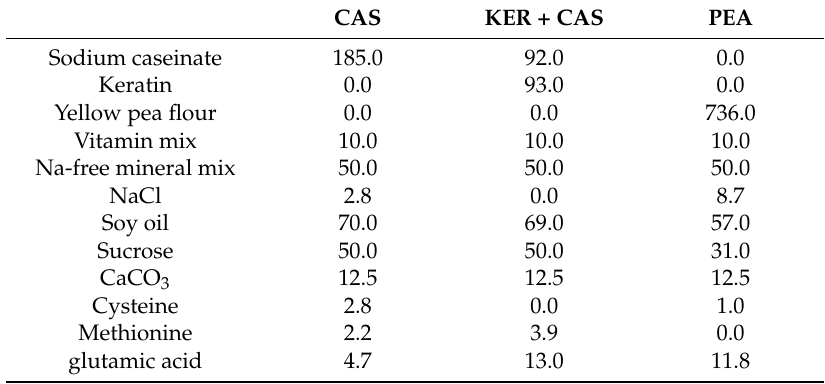
Table 2. Formulation of test diets (ingredients added at g/kg final diet) containing protein sourced from casein (CAS), 50:50 w/w keratin and casein (KER + CAS), or yellow pea flour (PEA). CAS KER + CAS PEA Sodium caseinate